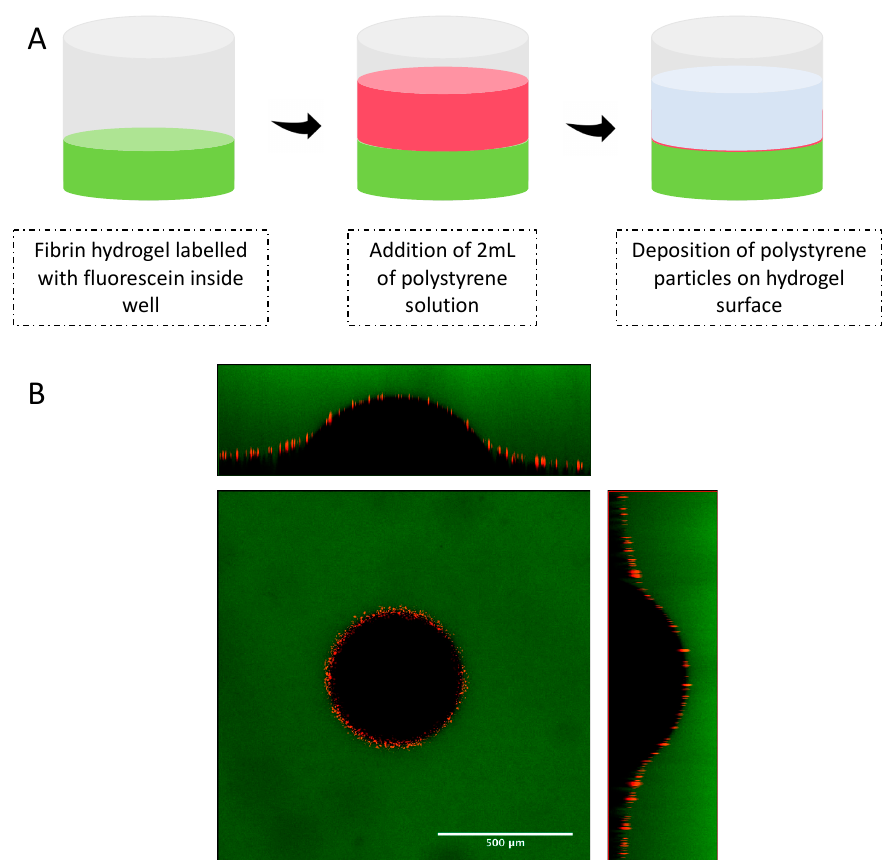
Figure 1. Set-up for indentation experiment: ( a ) Hydrogel samples were labelled with fluorescein sodium salt (green) while red polystyrene particles were deposited on its surface (red). Spherical ceramic indenters were positioned on the surface of the fibrin samples, generating an indentation depth. ( b ) Indentation depths were measured by visualizing cross section images obtained in the axis of symmetry of the gel indented surface. Scale bar represents 500 μ m.